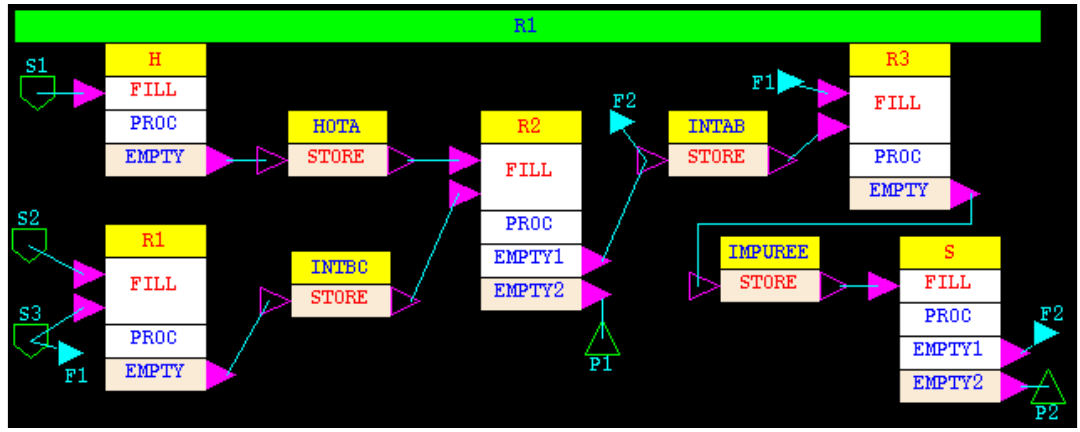
Table 4. Key process parameters for Example 4.